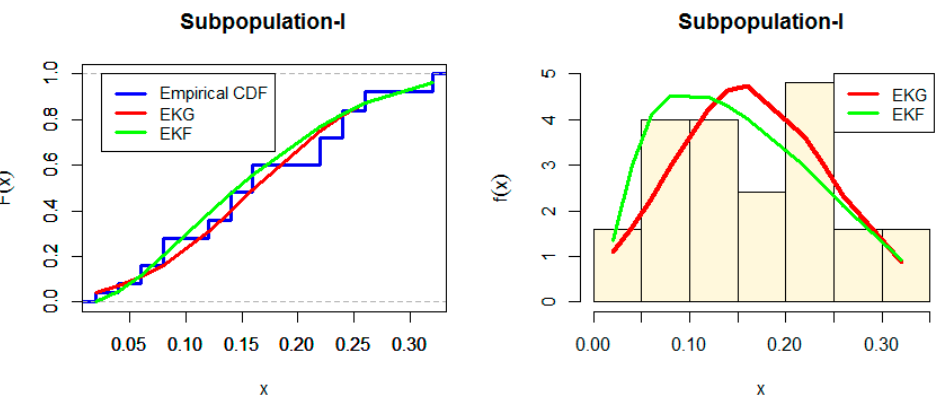
Figure 2. Estimated CDF and PDF for EKG and EKF distribution for Subpopulation I.